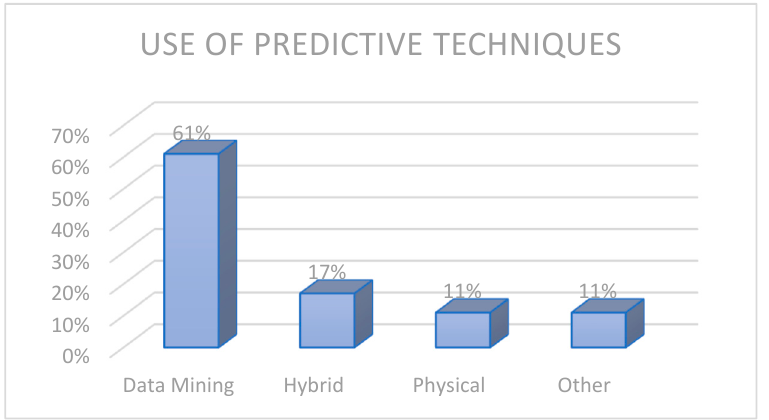
Figure 2. Predictive technique type classification [14].